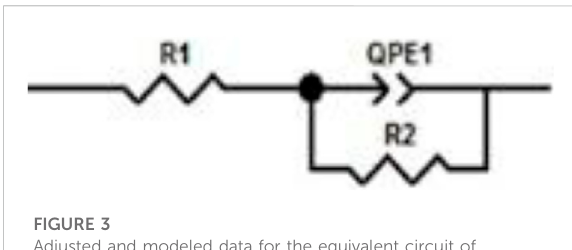
FIGURE 3 Adjusted and modeled data for the equivalent circuit of corrosion inhibition for 1018 steel in acid media with 500 ppm concentration of M. sativa and the addition of 5 mM of